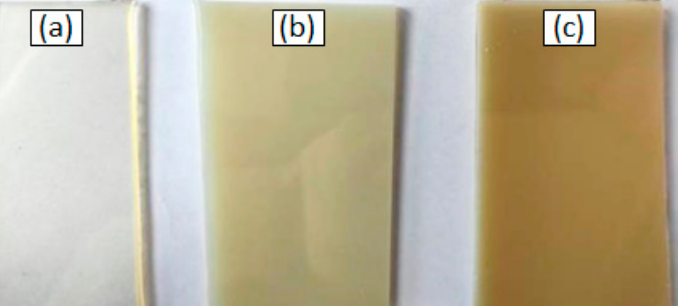
Figure 5. Color change and a decrease in transparency with an increase in the amount of polysulfone in the composition of the sample: ( a ) sample without dopant; ( b ) sample with 5 wt.% of PSU-BPZ; ( c ) sample with 5 wt.% of